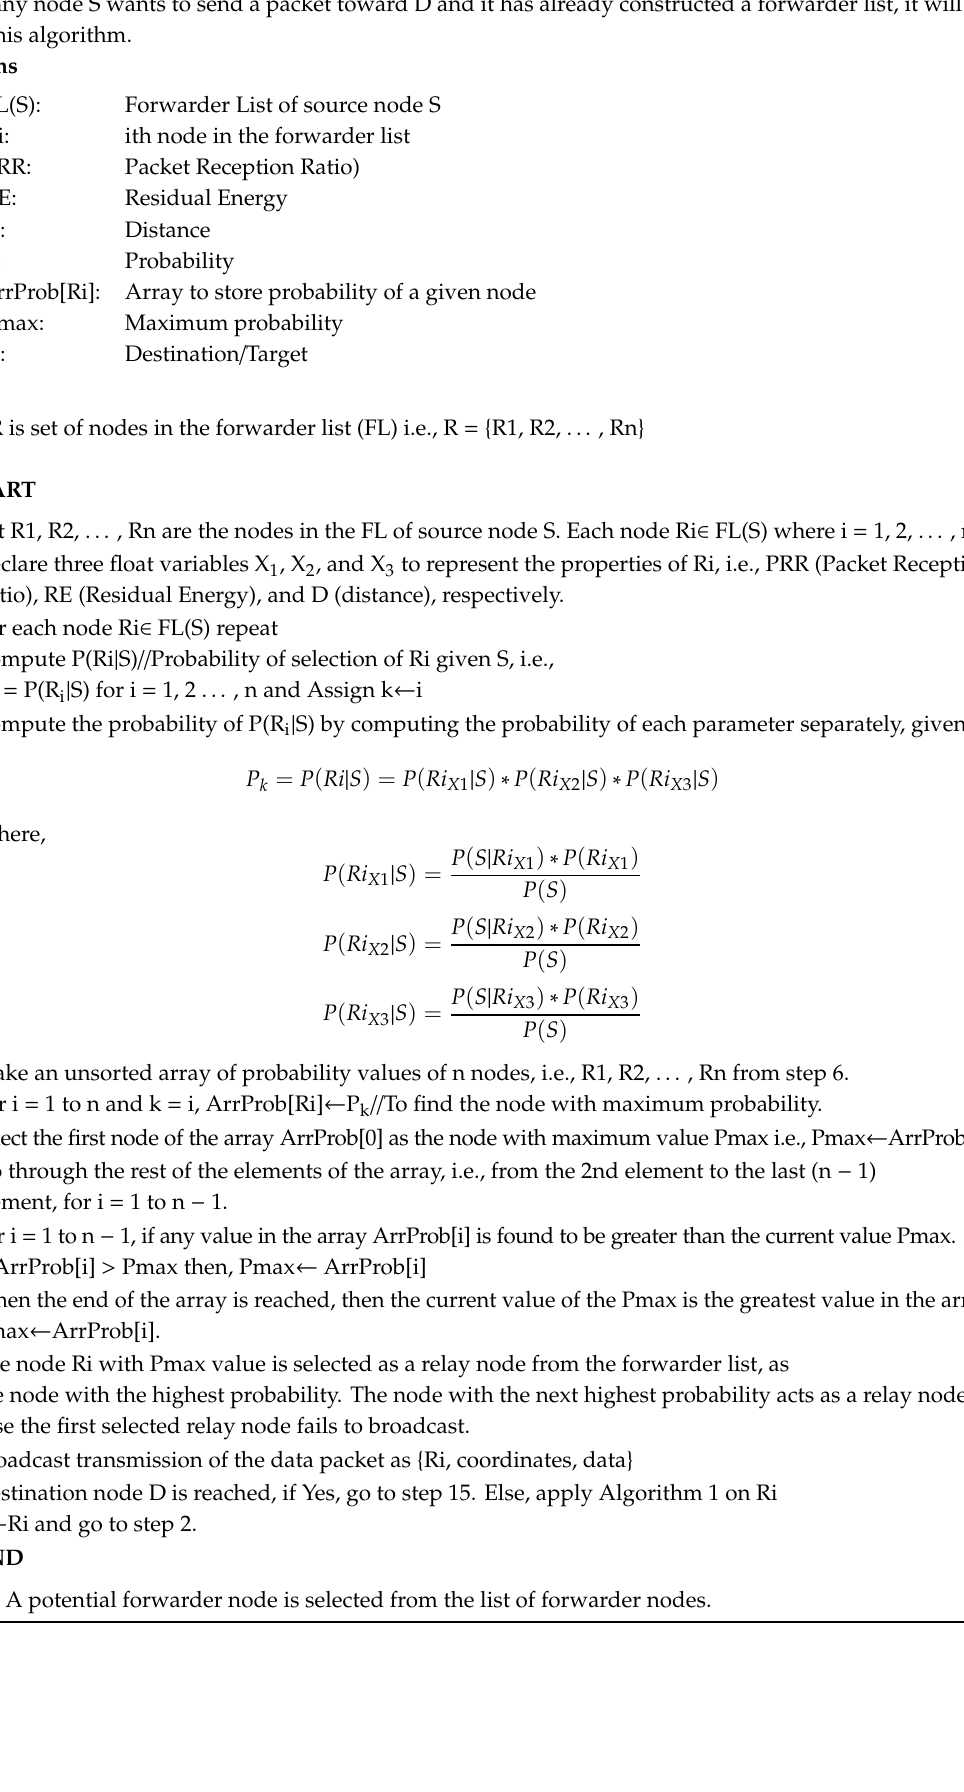
Algorithm 2. Forwarder_Node_Selection (S = Source, D = Destination) // when any node S wants to send a packet toward D and it has already constructed a forwarder list, it will follow this